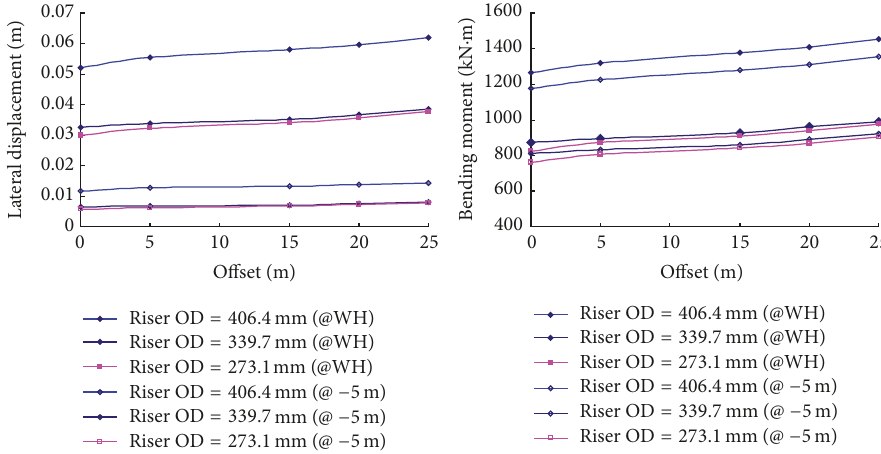
Figure 12: Effect of the platform surge amplitude and riser size on wellhead and conductor.